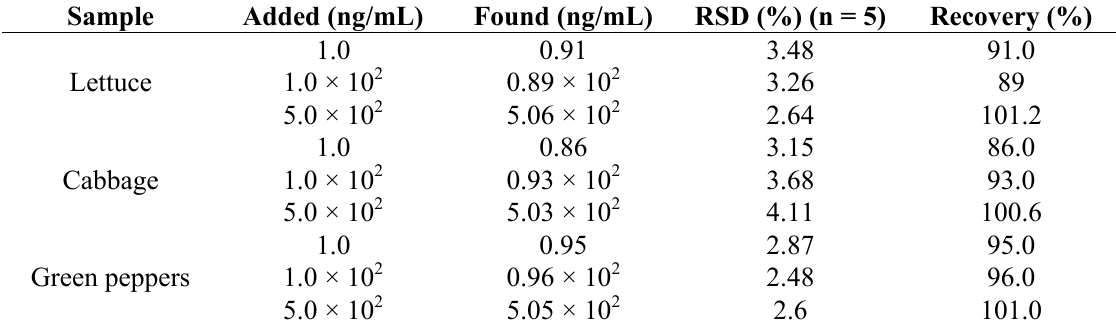
Table 2. The recovery of the proposed immunosensor in real